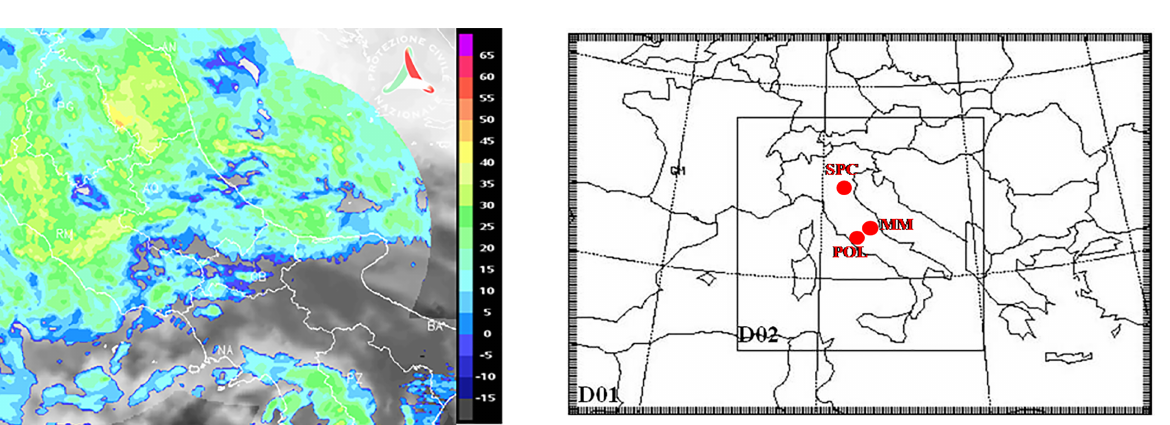
Figure 4. Close-up over central Italy of the reflectivity on 14 September 2012 at 08:00UTC from the Italian radar network overlapped with the MSG (IR 10.8) at 07:30UTC. (Courtesy of Ital- ian DPC.)